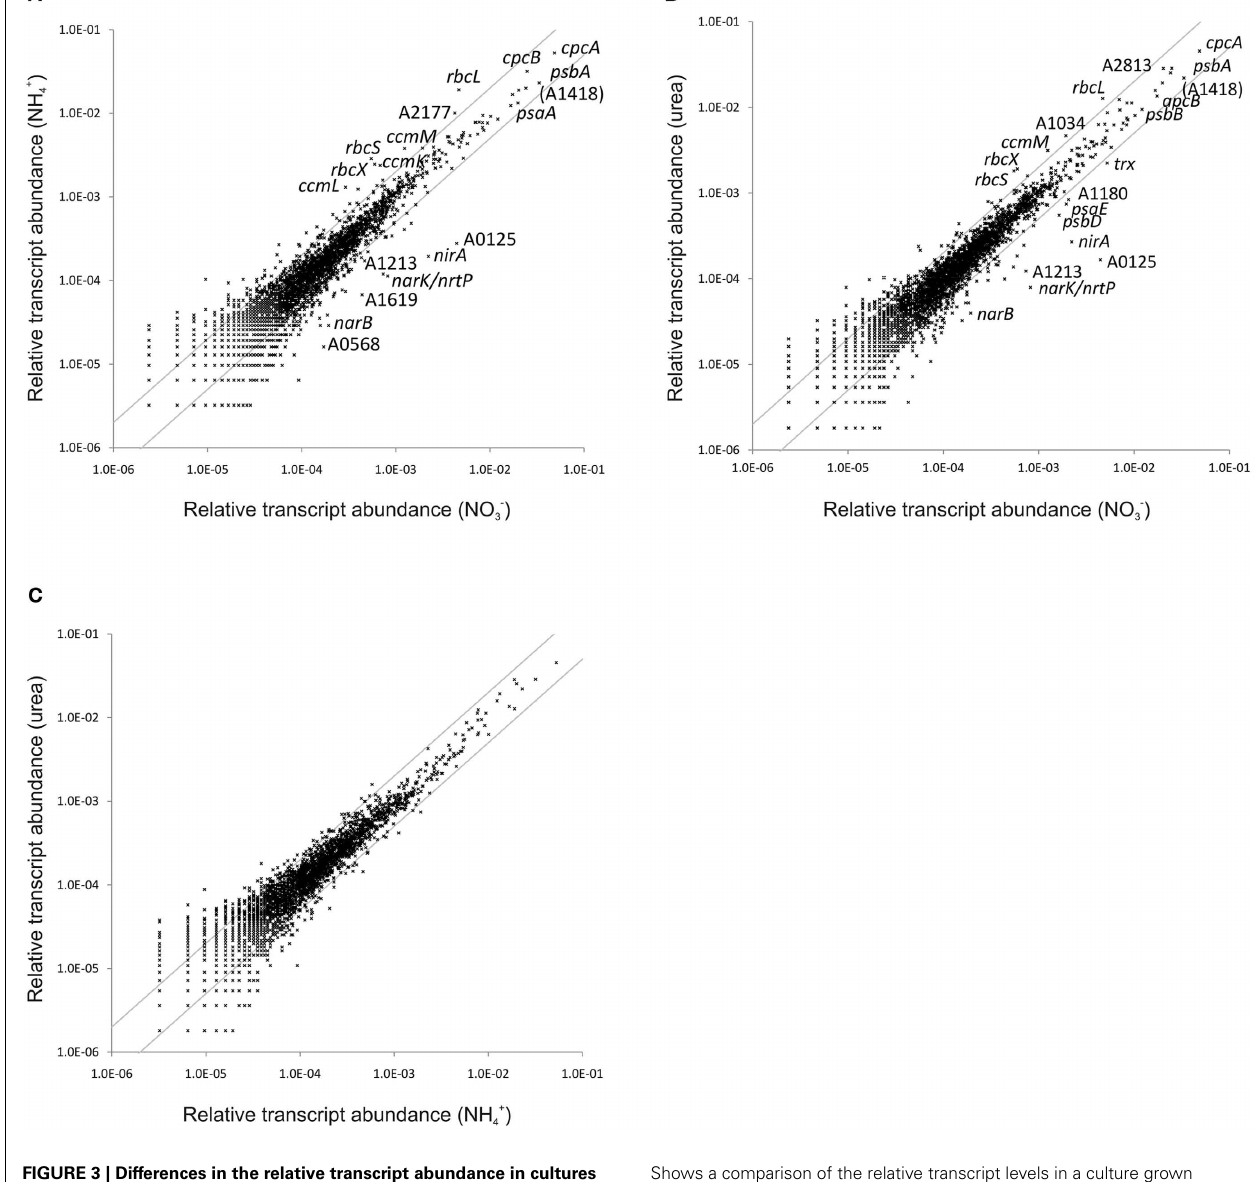
FIGURE 3 | Differences in the relative transcript abundance in cultures grown with different nitrogen sources. The scatter plots show the relative transcript abundances of a culture grown with (A) ammonia and (B) urea as nitrogen source compared to a culture grown with nitrogen. (C)